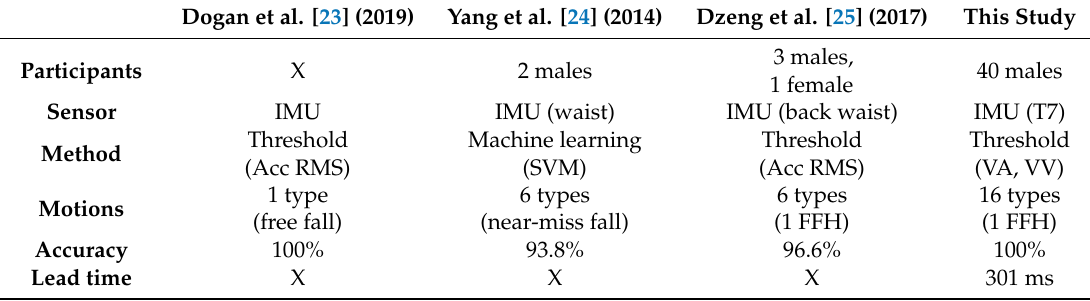
Table 8. Comparison with other